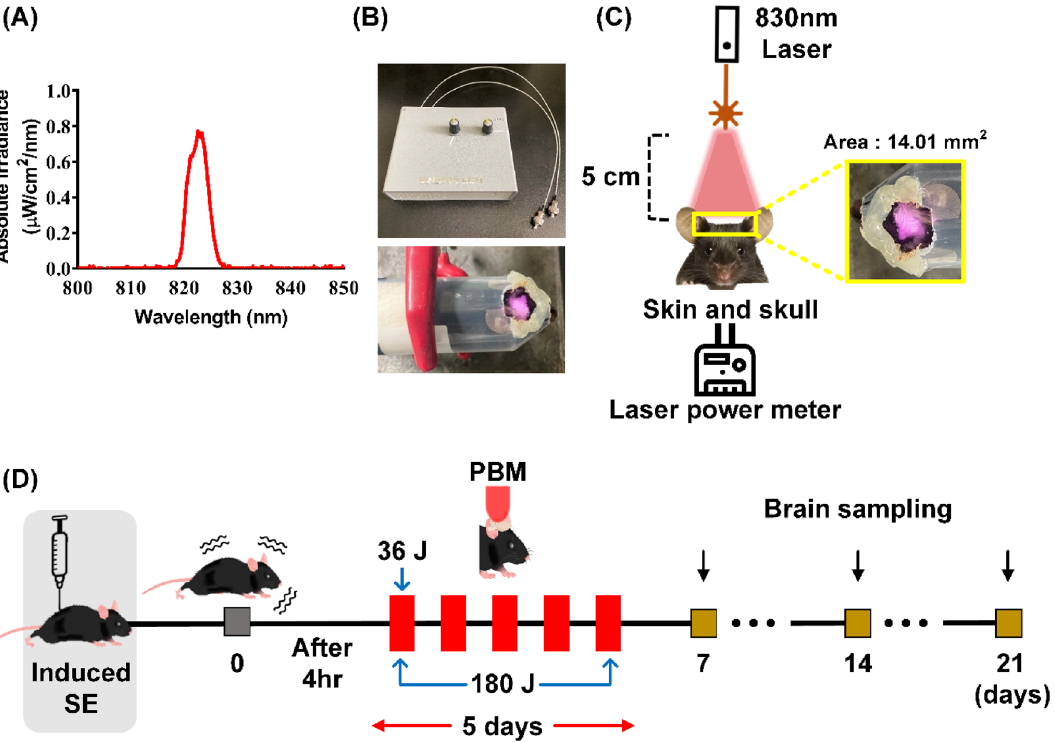
Figure 1. PBM irradiation and experimental schedule. ( A ) Beam profiling of PBM using a spectrophotometer. An 830 nm laser with specific narrow wavelength was used to irradiate the SE mouse model. ( B ) Experimental setup for treatment with PBM. After the hair on the head was depilated, the mouse was placed in the 50 ml tube with a hole in the head position to fix the movement, and then an 830 nm laser was used for irradiation for 12 min at a distance of 5 cm with a power of 50 mW/cm 2 . ( C ) The scalp was irradiated with an area of 14.01 mm 2 , and laser transmission were measured by power-meter detector. ( D ) 830 nm laser was irradiated at 4 h after SE-induction only once as 36 J or during 5 days as total 180 J. Then, brains were collected for the epifluorescence analyses on days 7, 14, or 21. This figure was generated with Microsoft Visio version 2016 (Microsoft, Redmond, WA,